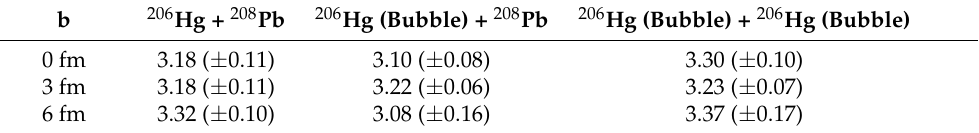
Table 1. π − / π + ratio at E beam = 300 A